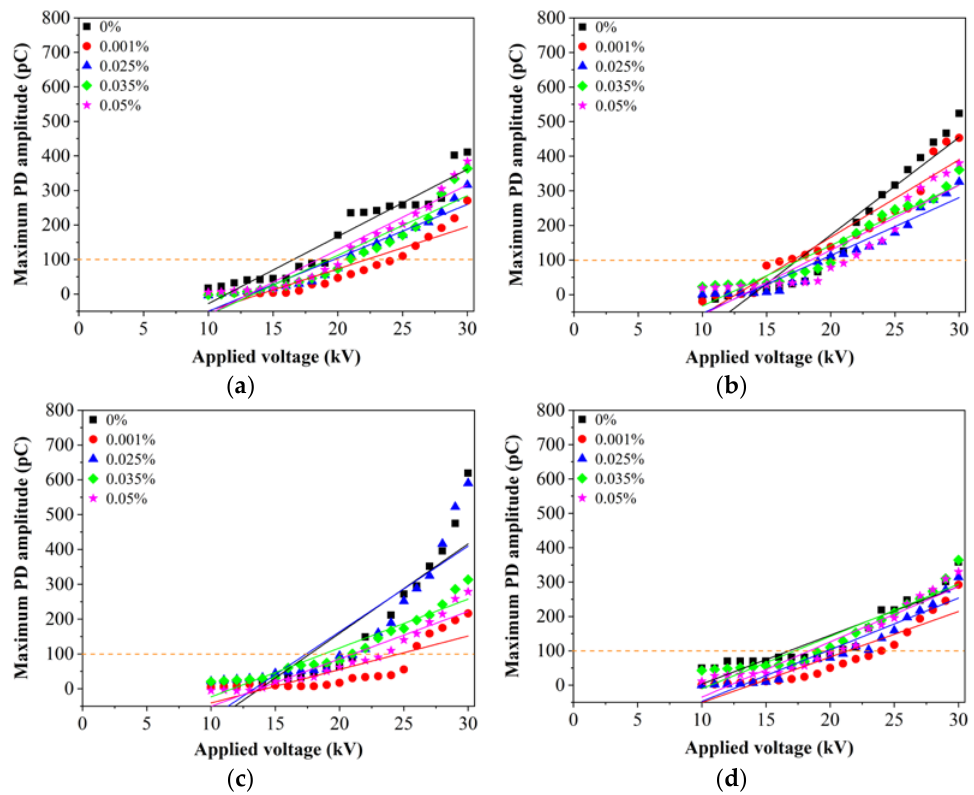
Figure 7. Maximum PD amplitude versus applied voltage for ( a ) RBDPOA, ( b ) RBDPOB, ( c ) CO and ( d ) MO based Al 2 O 3 with SDS.